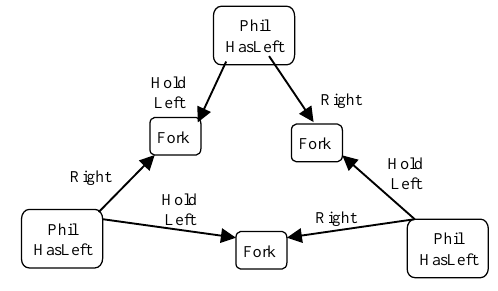
Figure 5. The final state graph for the dining philosophers problem with 3 philosophers and 3